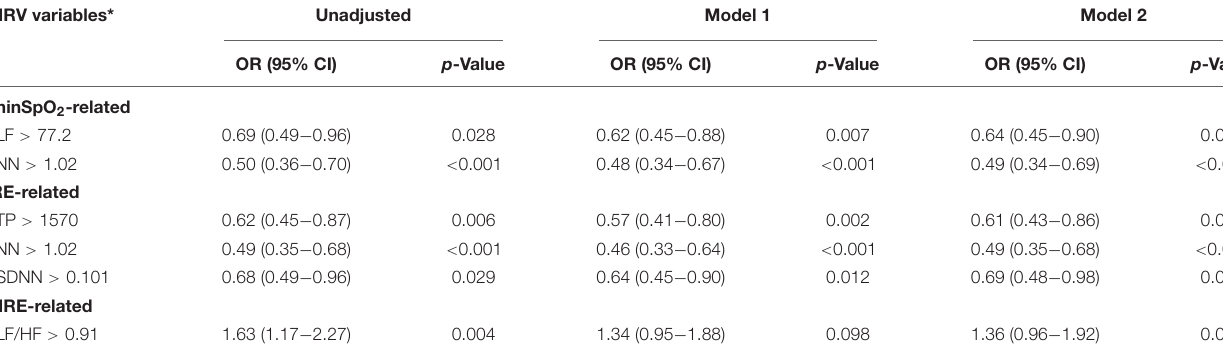
TABLE 5 | Significant sleep apnea-specific heart rate variability parameters associated with AMI